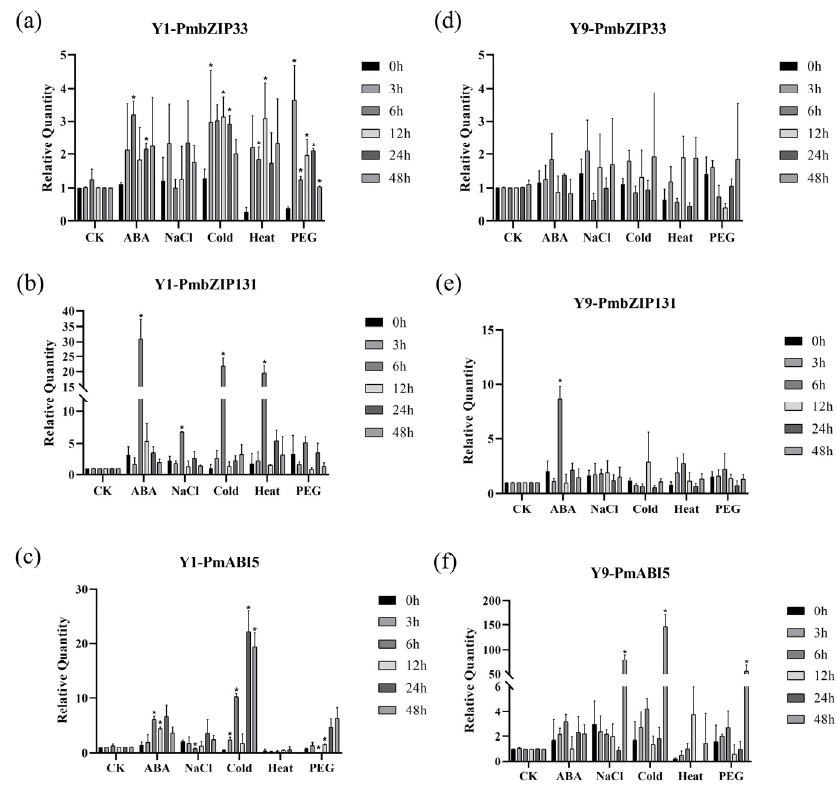
Figure 5. Expression pattern of PmbZIPs in the seedling stage. Error bars are SD based on three biological replicates and three technical repeats. *: p value < 0.05. ( a ) Expression levels of PmbZIP33 in Y1. The horizontal axis represents treatment with RO water (CK), 100 µ M ABA (ABA), 200 mM NaCl (NaCl), 4 °C cold incubation (Cold), 42 °C heat stress (Heat), and 20% PEG6000 (PEG). ( b ) Expression levels of PmbZIP131 in Y1. ( c ) Expression levels of PmbABI5 in Y1. ( d ) Expression levels of PmbZIP33 in Y9. ( e ) Expression levels of PmbZIP131 in Y9. ( f ) Expression levels of PmbABI5 in Y9.